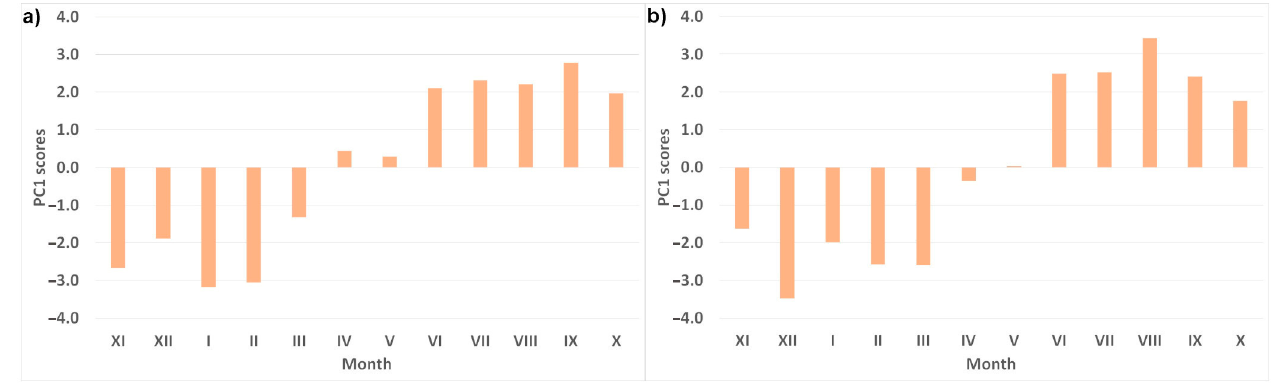
Figure 5. PC1 scores for the individual months in ( a ) 2018 and ( b ) 2019.